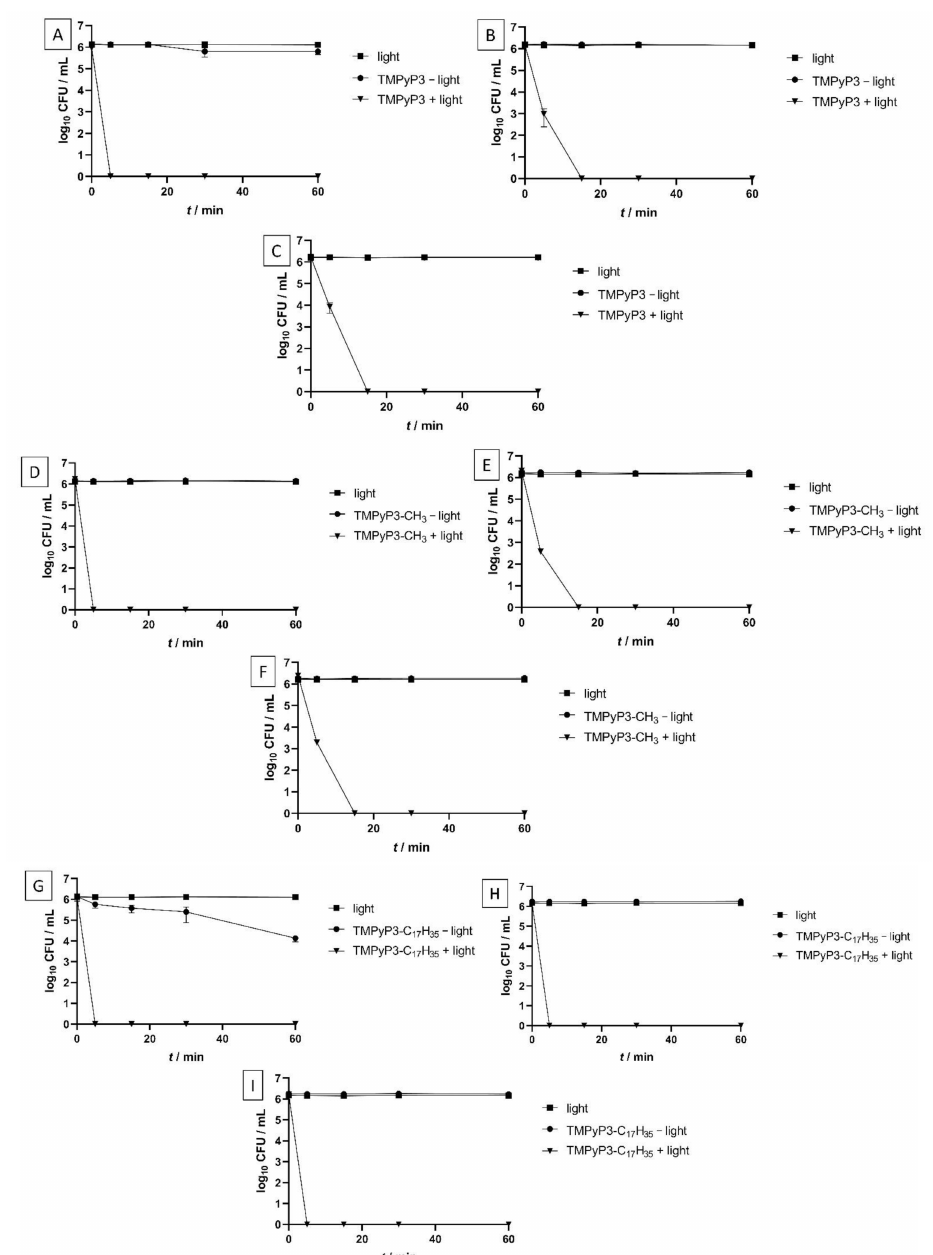
Figure 7. Photoinactivation studies of TMPyP3 ( A (DEMI), B (SW), C (HW)), TMPyP3-CH 3 ( D (DEMI), E (SW), F (HW)), and TMPyP3-C 17 H 35 ( G (DEMI), H (SW), I (HW)) in 0.5 × MEC concentrations. The samples were irradiated for 60 min with violet light (395 nm, total light dose (after 60 min irradiation) 72 J/cm 2 ). “PS − light” represents dark control, while “light” represents bacteria irradiated with light without presence of PS. All data are presented as an average ± SD. PDI was studied using PS concentration 0.5 × MEC determined in SW under irradia- tion for each PS, which was 1.563 µ M for TMPyP3-CH 3 and TMPyP3-C 17 H 35 and 3.125 µ M for